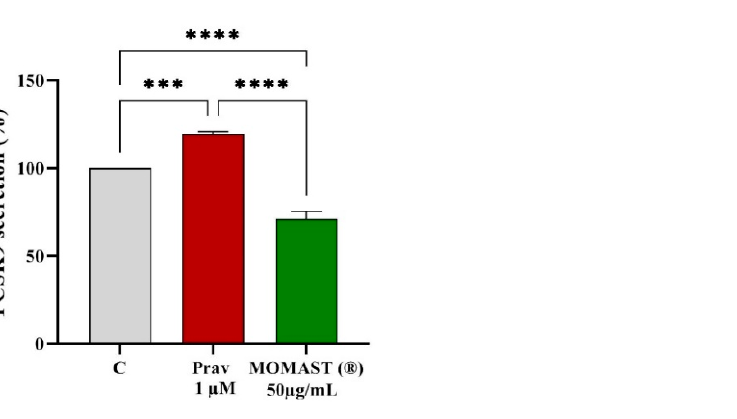
Figure 6. Impact of MOMAST ® on the PCSK9 secretion level. Data points represent averages ± SD